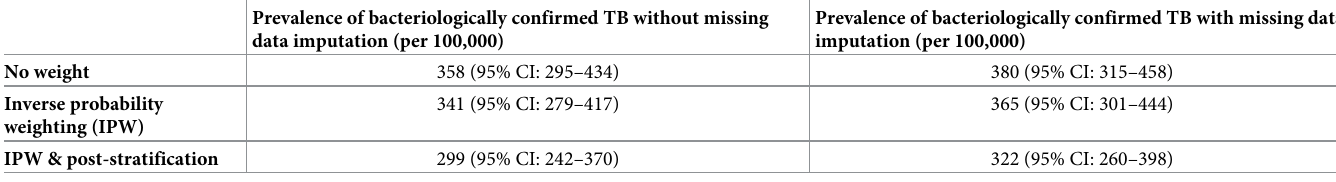
Table 5. Comparing the prevalence of bacteriologically confirmed TB with and without missing data imputation, inverse probability weighting and post- stratification. Prevalence of bacteriologically confirmed TB without missing data imputation (per 100,000)